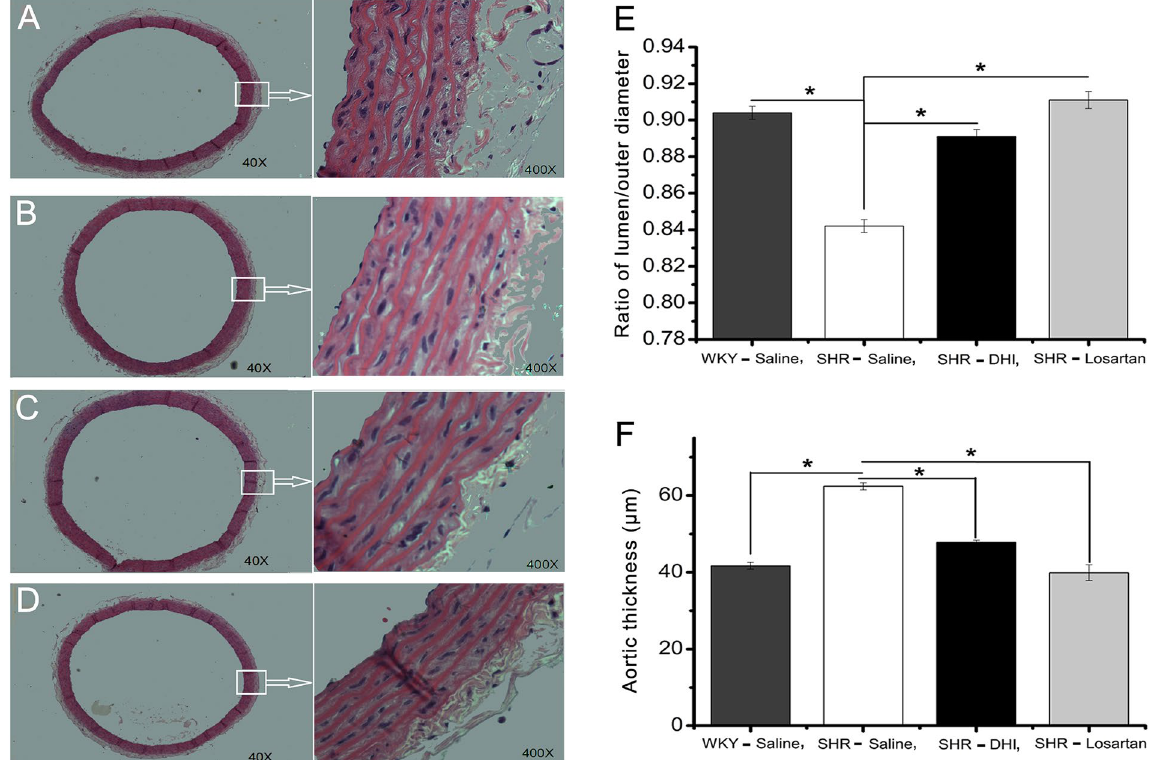
Figure 5. Effect of DHI on vascular remodeling in SHR. Histology of H&E stain of thoracic aorta at x40 and x400 ( A – D ) are shown. Summarized ratio of the inner to outer diameter of the thoracic aortas from the 4 groups of rats are quantified and presented in ( E and F ). ( A ) Saline treated WKY rats; B: Saline treated SHR rats; ( C ) SHR rats treated DHI; ( D ) SHR treated Losartan. Values represent mean ± SEM (n = 4 per group; p < 0.01 vs. SHR treated